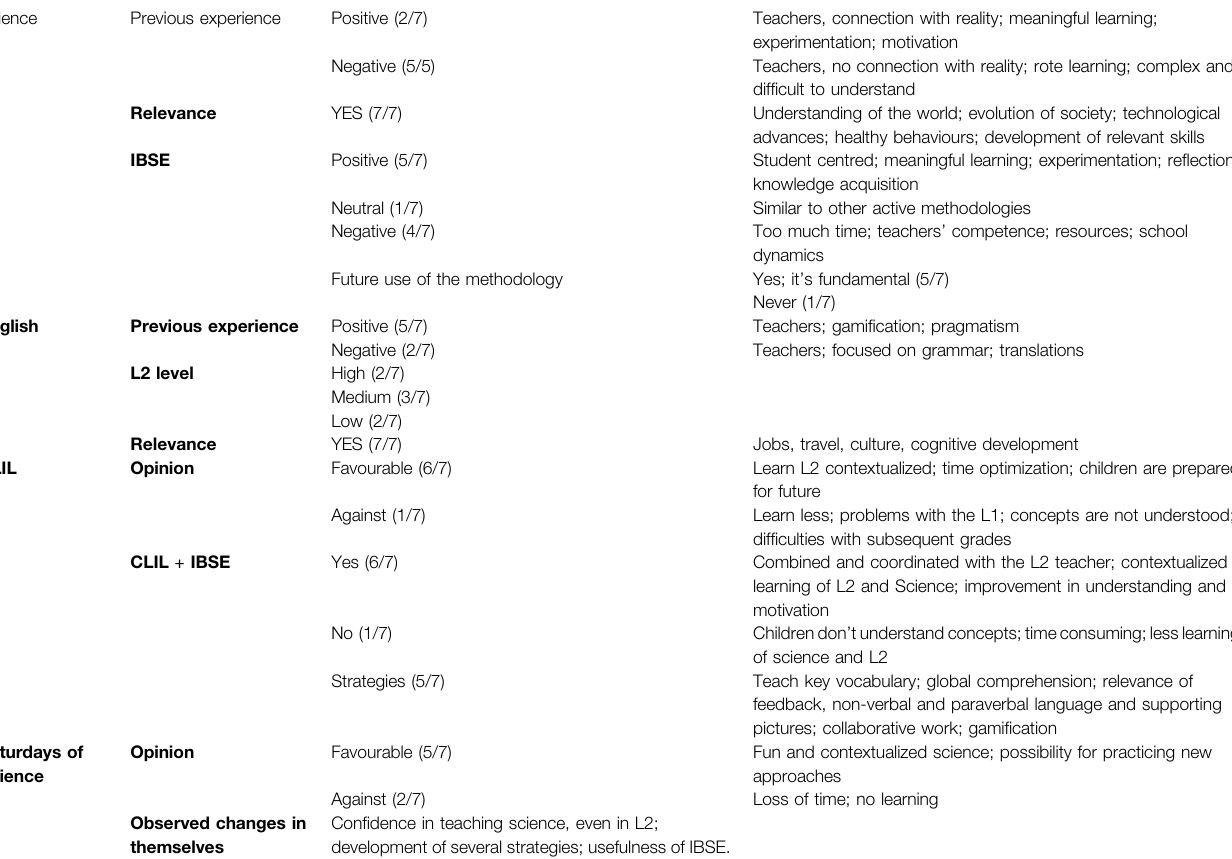
TABLE 3| Pre-serviceteachers ’ opiniononscience, English,ContentandLanguageIntegratedLearningandSaturdayofScience.Thenumber ofsubjectsineachcategory appear in parentheses.